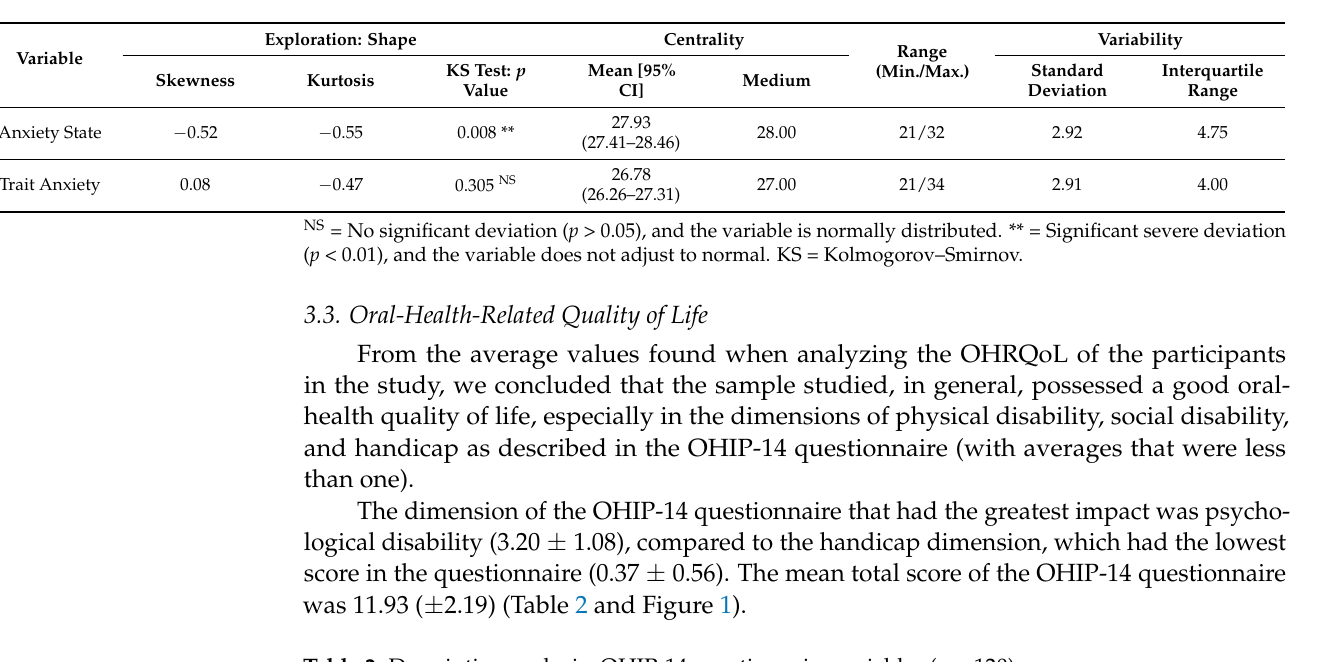
Table 1. Descriptive analysis. Variables in the STAI questionnaire ( n = 120).